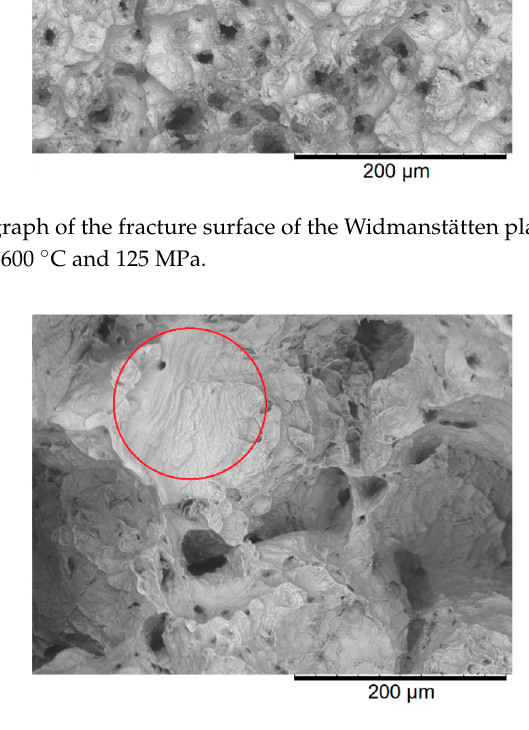
Figure 13. SEM micrograph of the fracture surface of the Widmanstätten plasma-nitrided Ti-6Al-4V alloy after creep test at 600 °C and 125 MPa.